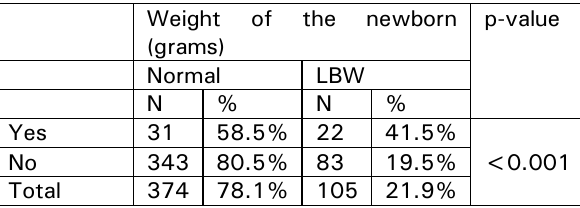
Table 4: Relationship of Smoking with